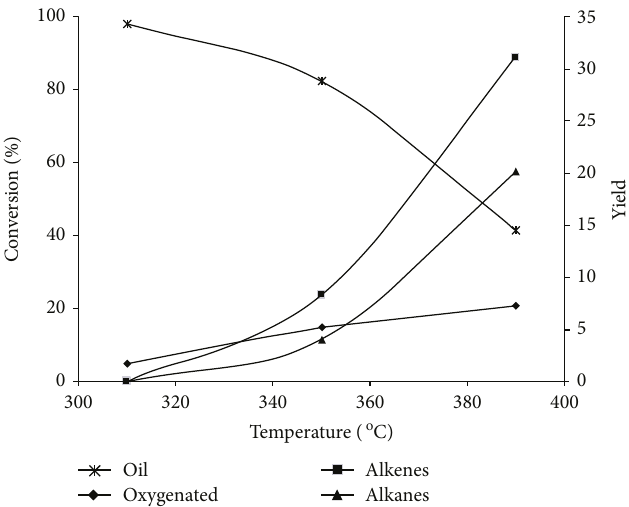
Figure 7: Catalytic activity for Jatropha curcas L. seed oil. Catalytic selectivity in functional groups for bifunctional catalyst 0.01% Pt and 20% USY/Al O at WHSV=35.28 h − 1 2 3